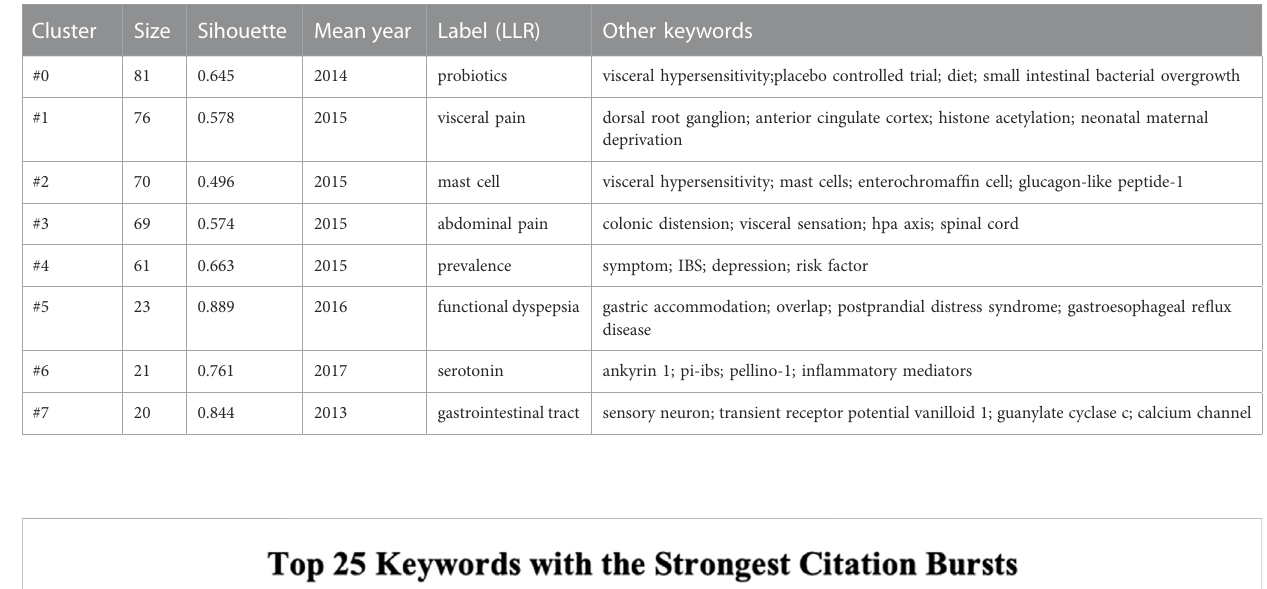
TABLE 5 Keyword cluster analysis.